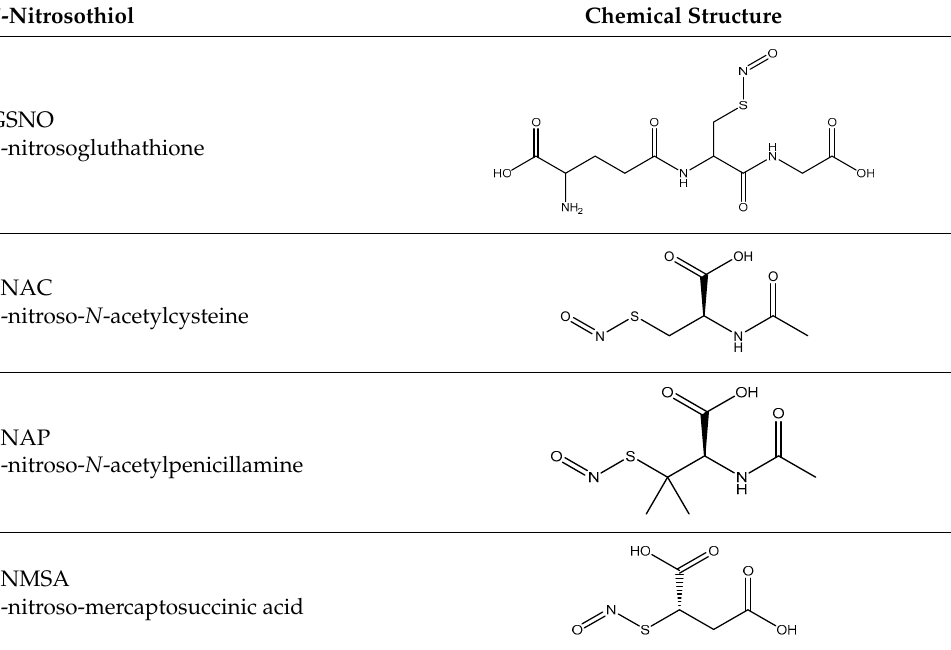
Table 1. Chemical structure of the most used S-nitrosothiols.